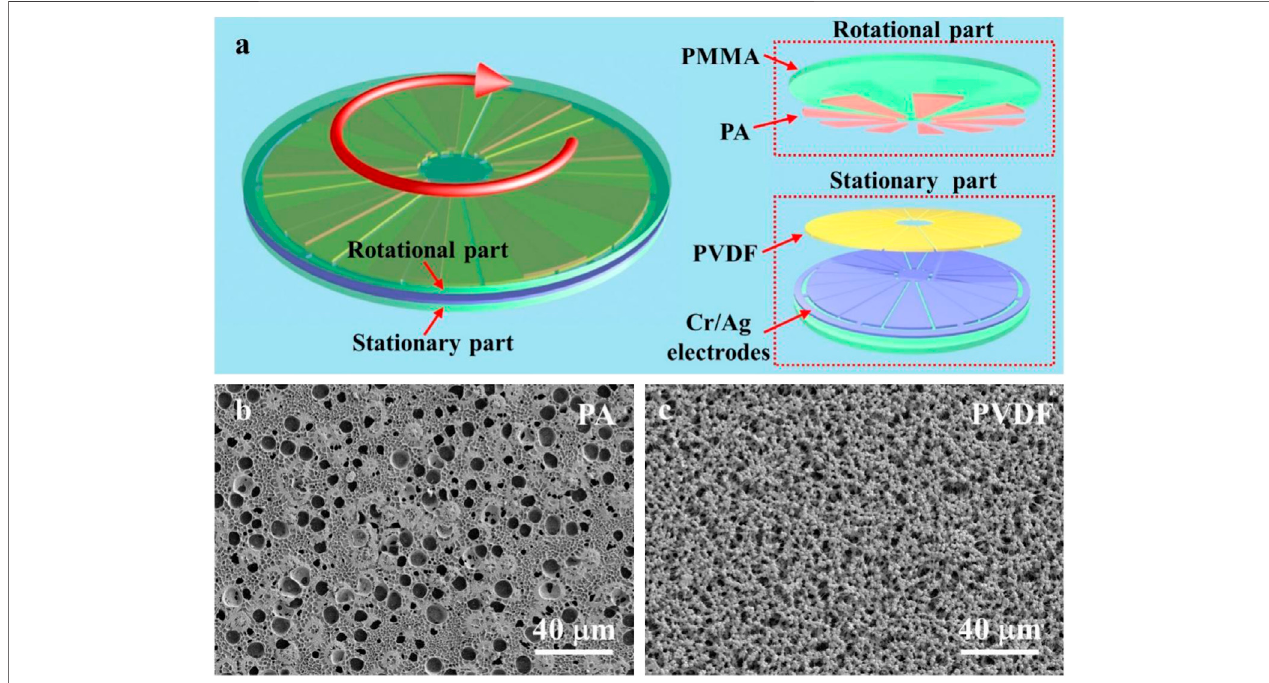
FIGURE 1 | Design of the D-TENG. (A) Schematic diagram of the D-TENG. (B) Scanning electron microscope (SEM) image of the spin-coated PA fi lm. (C) SEM image of the spin-coated PVDF fi lm.